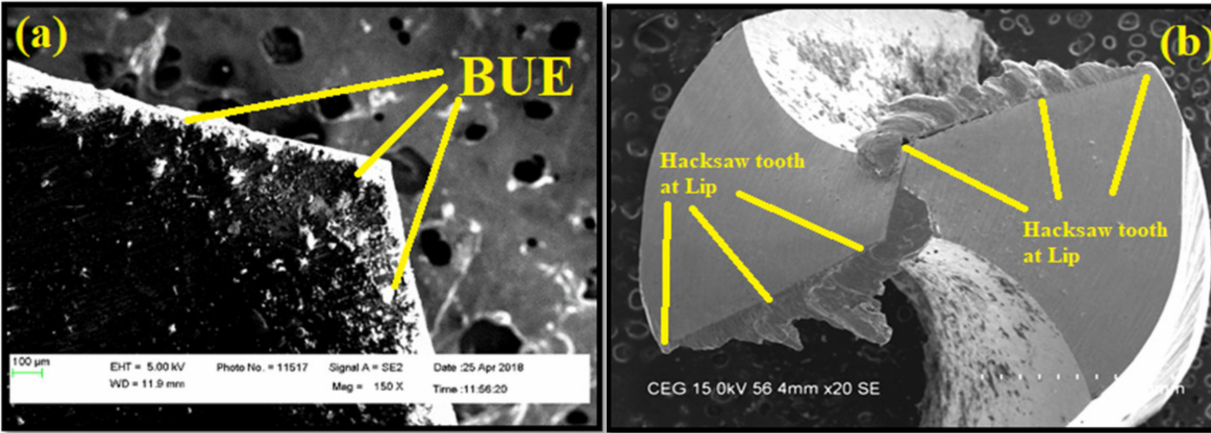
Figure 10. FESEM microscopic images of the ( a ) drill flank of AA7075, 0 wt.% of TiB 2 AMC at 1000 m/minute; and ( b ) drill tip face AA7075, 3 wt.% TiB 2 AMC at 1000